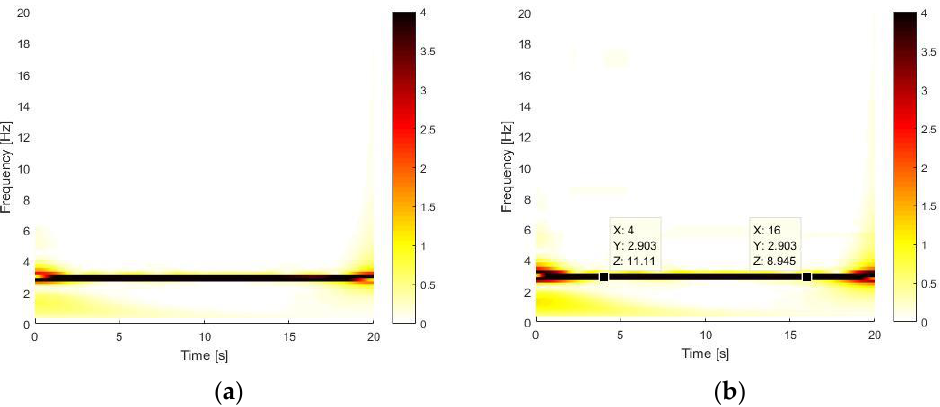
Figure 13. Time – frequency contents of BD test using CWT method for P11 (intermedial) ( a ) and P14 (mass) ( b ) profilometer points.